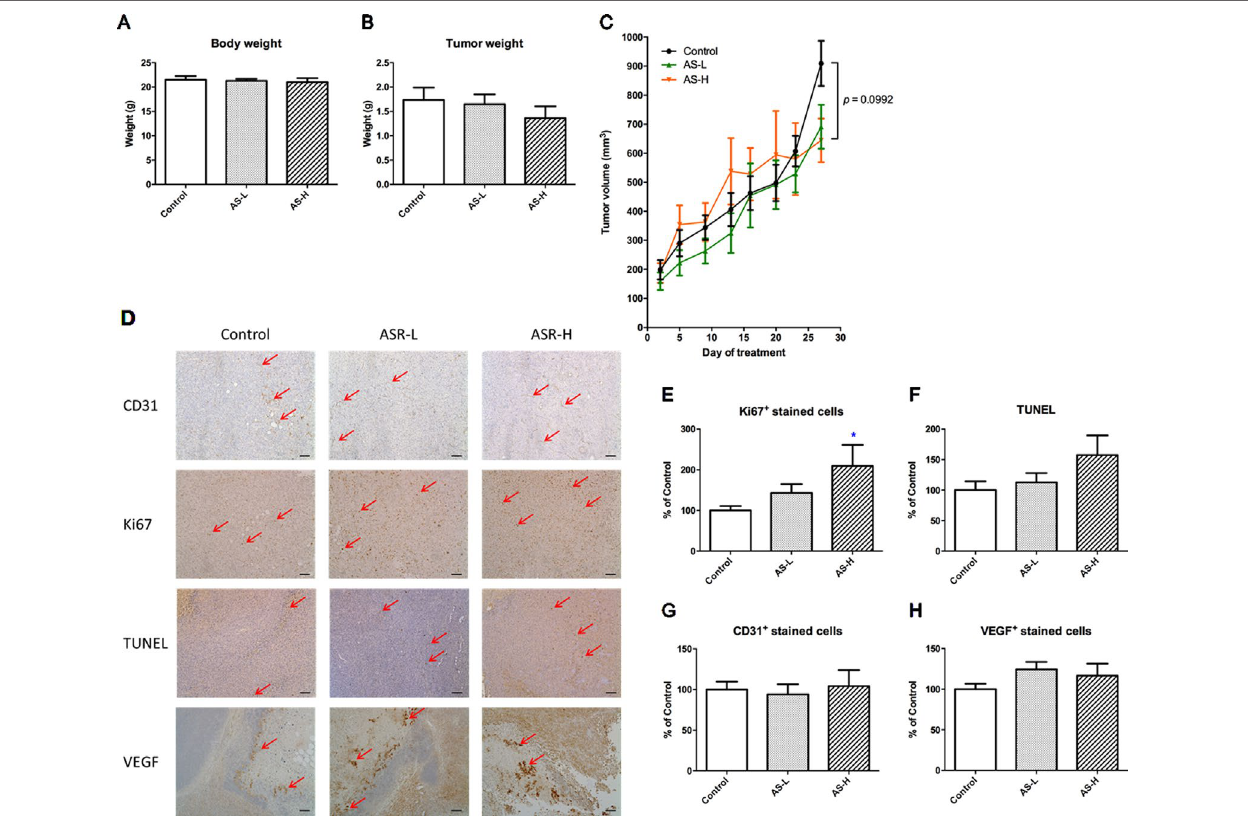
FIGURE 3 | Tumor growth of MDA-MB-231 xenograft-bearing mice. Mice were treated with AS-L (0.75 g/kg) or AS-H (1.5 g/kg) daily for 4 weeks. (A) Body and (B) tumor weights of mice after AS treatments were recorded at the end of treatment. Data were expressed as mean + SEM, n = 13–16. (C) Tumor volume of mice in each group was measured twice a week during treatments. (D) Effects of AS treatments on the expressions of Ki67, CD31, VEGF, and the apoptotic area (assessed using TUNEL assay) in the tumor sections excised from MDA-MB-231 xenografts-bearing mice. Representative images of immunohistochemical staining in the tumor sections (magnification = 100×, scale bar: 100 µ m). (E–H) Quantification of positive staining cells in tumor sections was conducted in a blinded manner. Data were expressed as mean + SEM, n = 13–16. Differences among treatment groups were determined by one-way ANOVA followed by post hoc Tukey’s multiple comparisons test. *p < 0.05, as compared with control